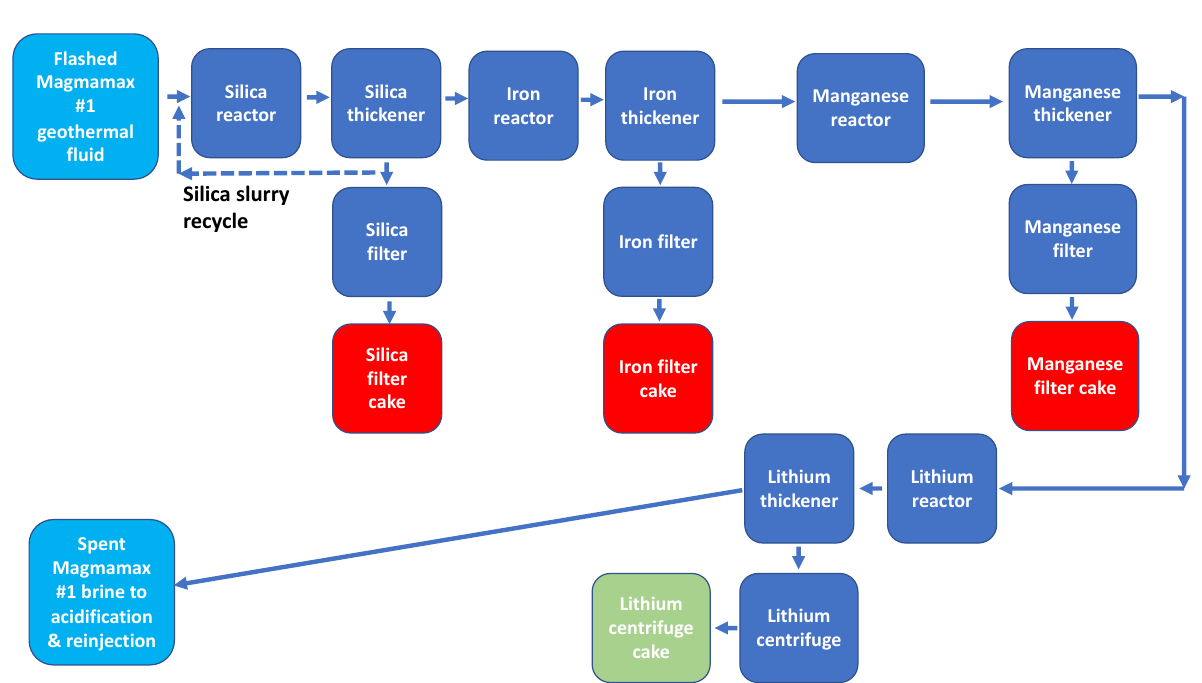
Figure 22. Process developed by Hazen International for the extraction of lithium from Salton Sea geothermal fluids, adopted from [31]. Reprinted (modified) from Geothermics, v. 11(4), Maimoni, Minerals recovery from Salton Sea geothermal brines: A literature review and proposed cementation process 239–258, Copyright 1982, with permission from Elsevier.